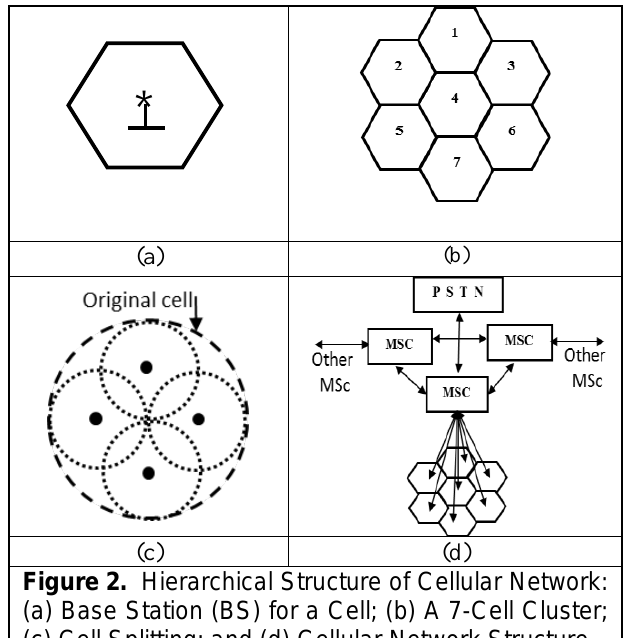
Figure 2. Hierarchical Structure of Cellular Network: (a) Base Station (BS) for a Cell; (b) A 7-Cell Cluster; (c) Cell Splitting; and (d) Cellular Network